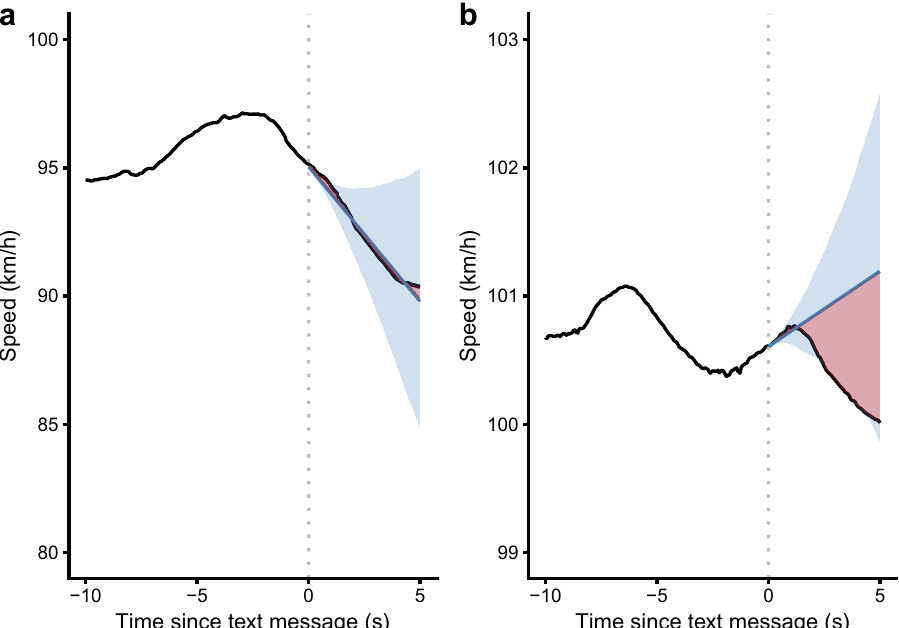
Figure 2. Two separate trials showing the Prophet modelling (blue line, with shaded blue area representing 95% confidence intervals) of vehicle speed. In plot ( a ), despite a large overall change in speed, there is little change in the speed trend, so the model fits well giving a mean absolute error (MAE, shown as red area) of 0.16 km/h. In plot ( b ), the participant changed their behaviour by lifting their foot off the accelerator pedal shortly after the text message arrived, which meant the model fit more poorly, yielding a higher MAE value of 1.18